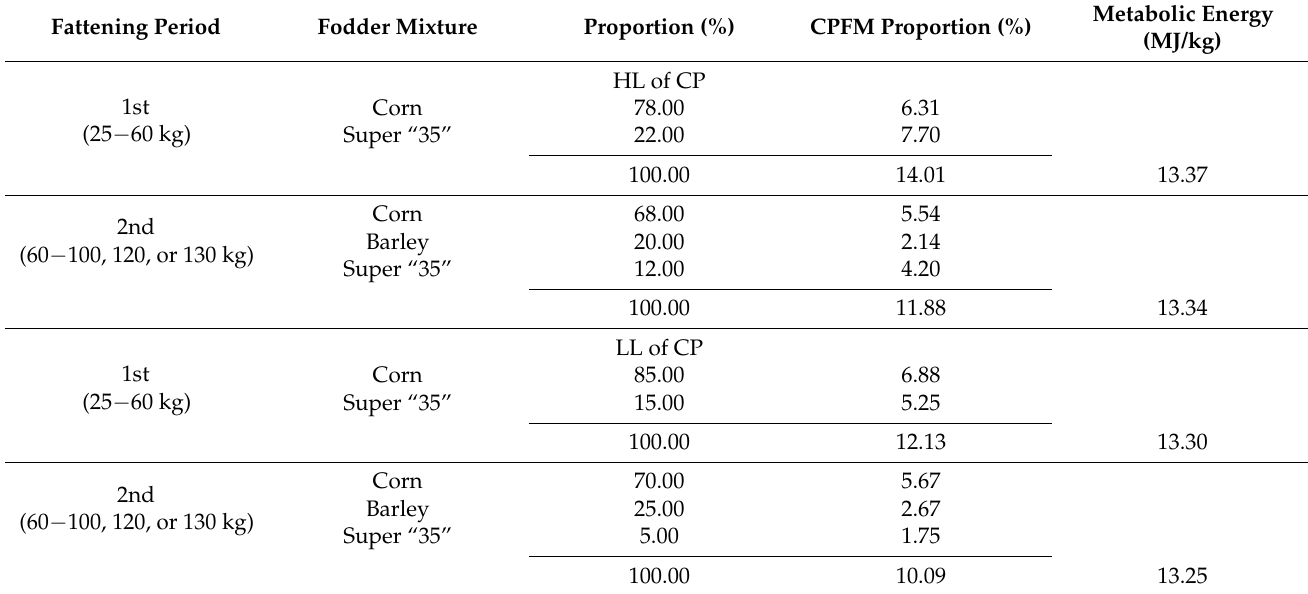
Table 1. The mixing ratio of grains and superconcentrate “35” in the experimental